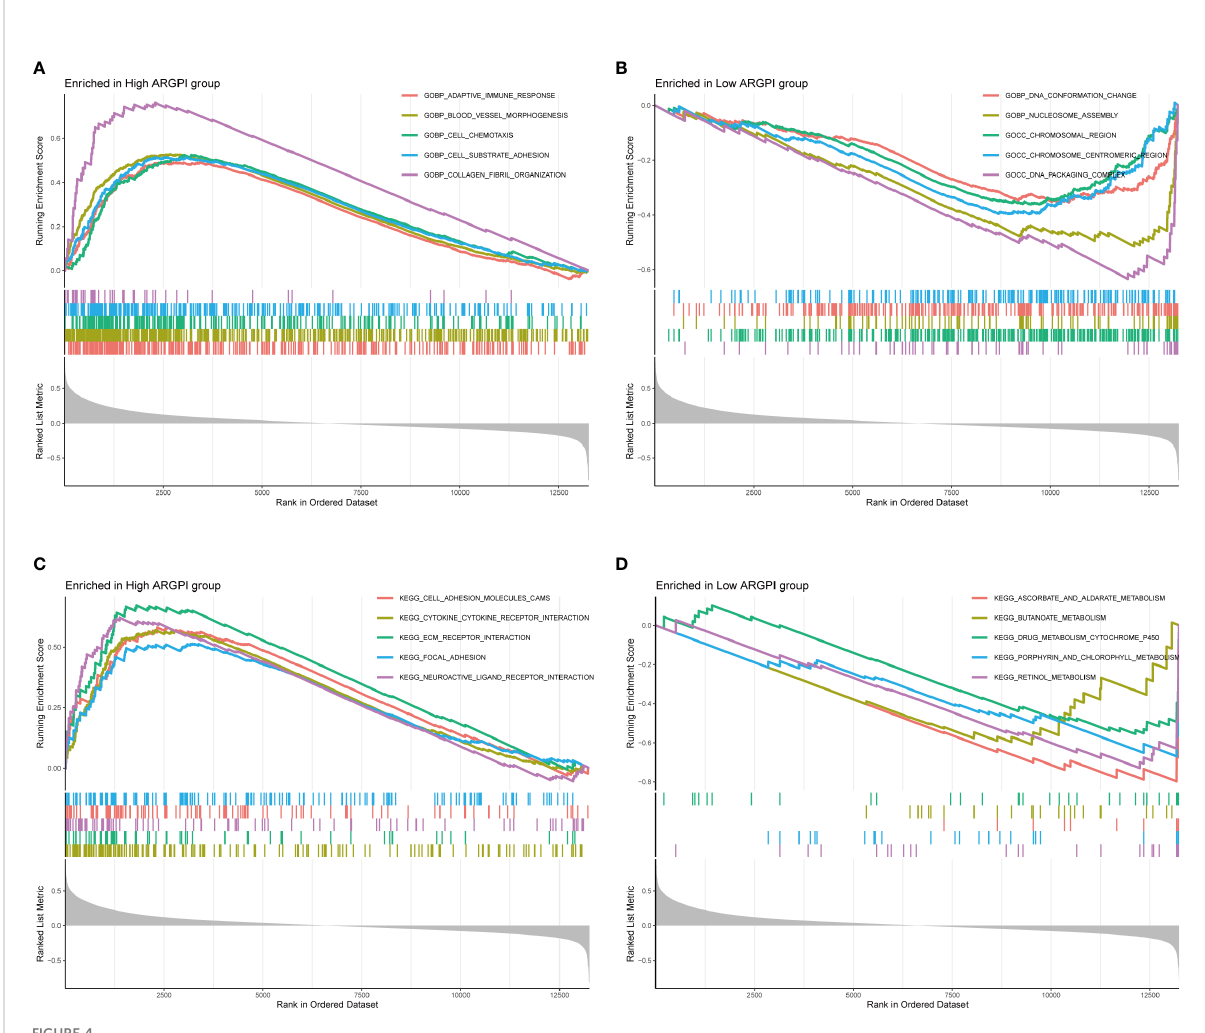
FIGURE 4 Gene Set Enrichment Analysis of ARGPI. (A, B) The 5 biological processes that were most signi fi cantly enriched in the high ARGPI group and the low ARGPI group, respectively. (C, D) The 5 signal pathways that were most signi fi cantly enriched in the high ARGPI group and the low ARGPI group,